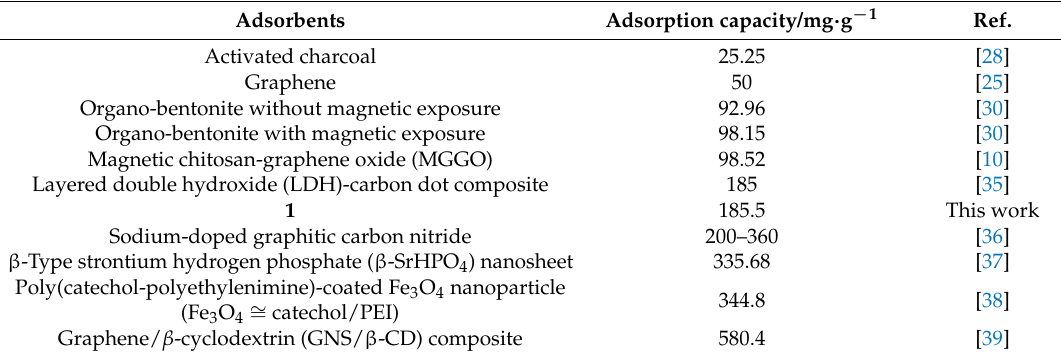
Organo-bentonite with magnetic